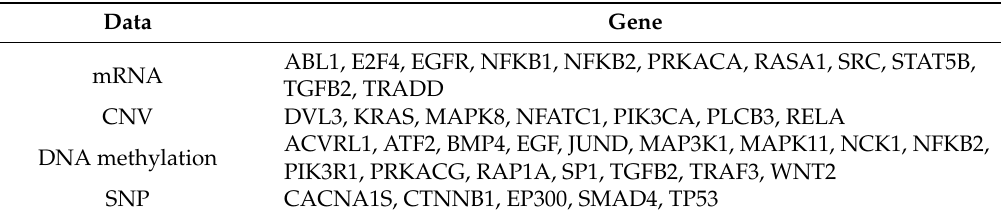
Table 3. Genes selected from each form of omics data.